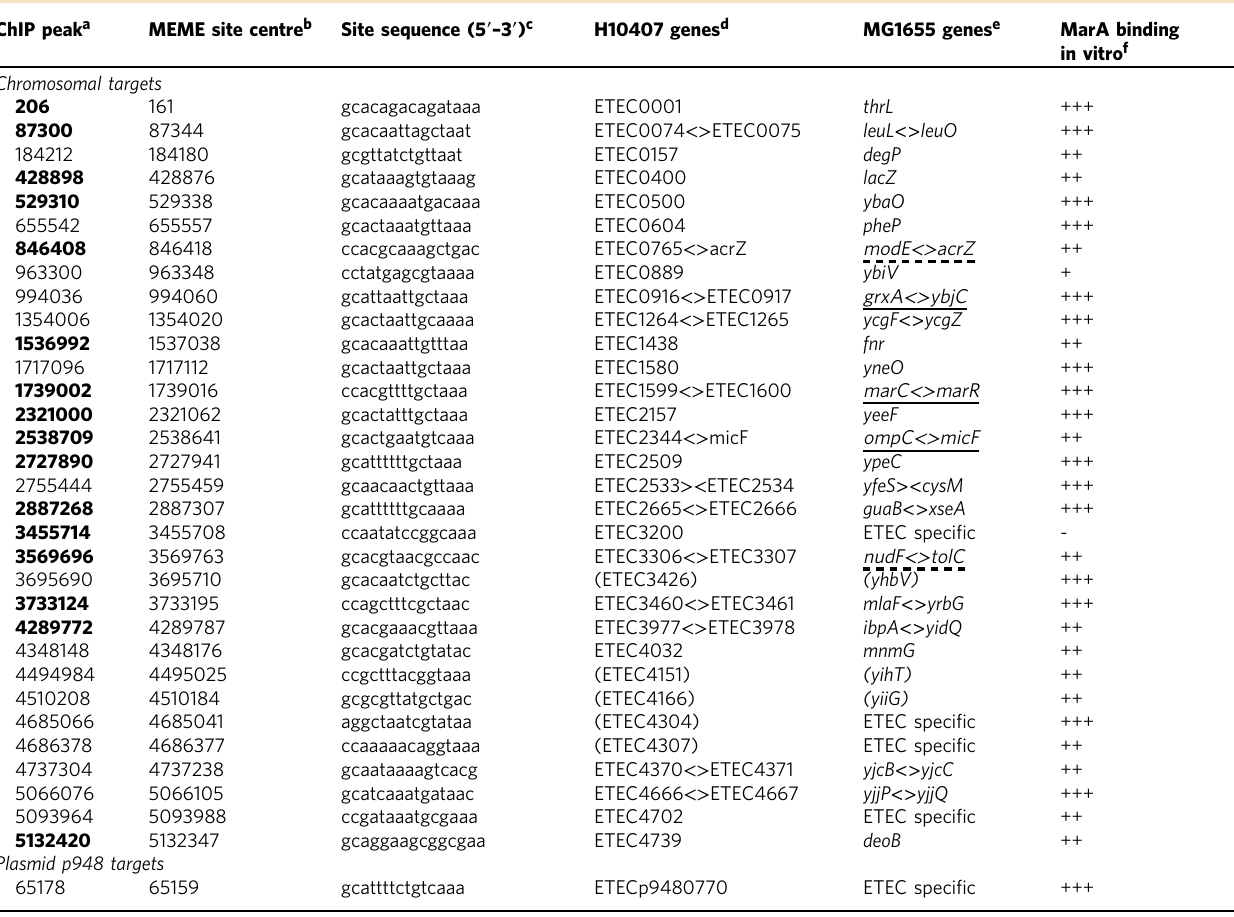
a Genome coordinate of MarA ChIP-seq peak centre in H10407. Bold type indicates peaks within 150bp of a σ 70 binding peak b Genome coordinate of MarA binding site predicted by MEME c Sequence of MarA binding site predicted by MEME d Nearest gene to MarA binding site. Some MarA targets were between divergent ( <> ) and convergent ( >< ) genes. Genes in parentheses indicate that the ChIP-seq peak is located within that gene e E. coli K-12 homologues of ETEC genes in the previous column. E. coli K-12 MarA binding sites, listed in the Ecocyc database, are highlighted according to experimental con fi rmation (solid line) or prediction (dashed line) f In vitro binding of puri fi ed MarA observed at a concentration of 0.3 μ M (+++), 1.0 μ M (++) or 1.7 μ M (+) (Supplementary Fig. 1a). Note that fi ve control DNA fragments ( cydD , ybiS <> ybiT , ETEC2117, cyoA and P estA ) did not bind MarA at any of these concentrations (Supplementary Fig.